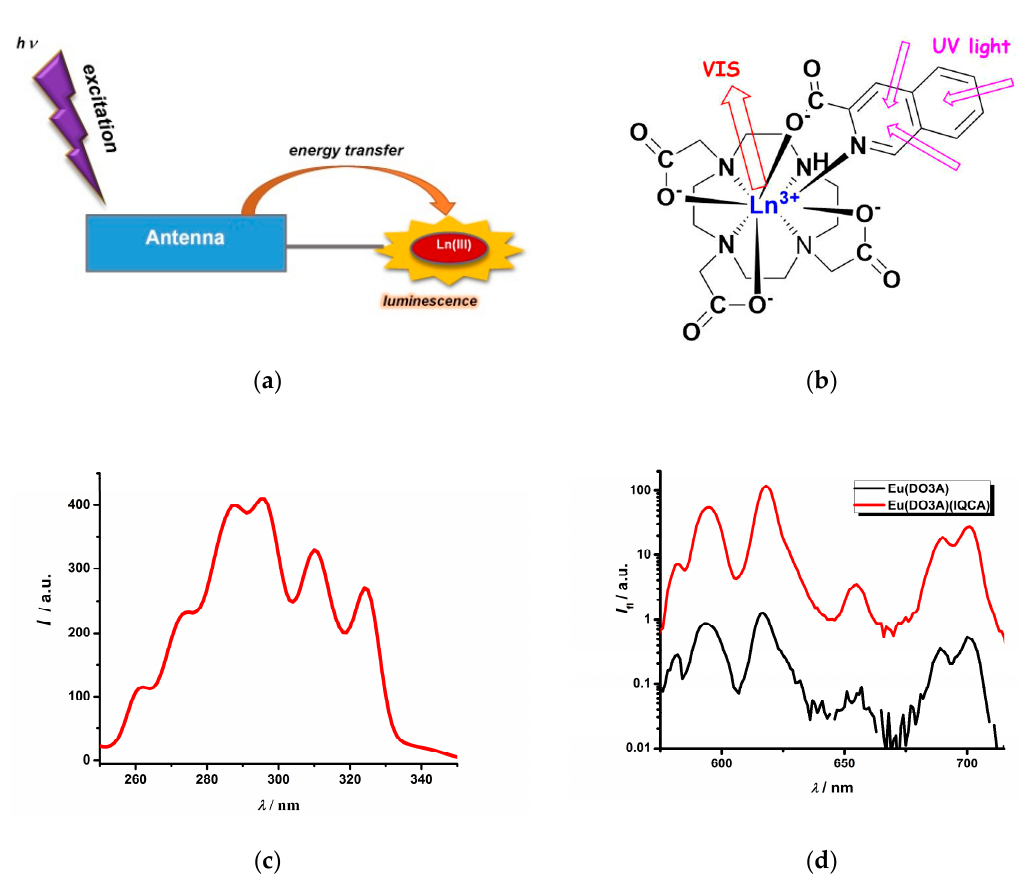
Figure 1. The antenna effect of ternary Ln(III) complexes with DO3A macrocyclic and 3-isoquinolinecarboxylate (IQCA) ligands ( a , b ). The excitation spectra ( c ) of Eu(DO3A)(IQCA) ( λ em = 618 nm) and emission spectra ( d ) of both binary and ternary complexes ( λ exc = 325 nm). The concentration of the Eu(III) complex is about 0.1 mM.